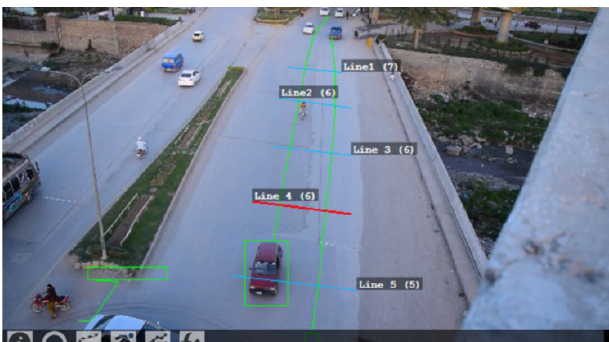
Figure 7. Vehicle speeds over a period of 1442s on 50 m road section